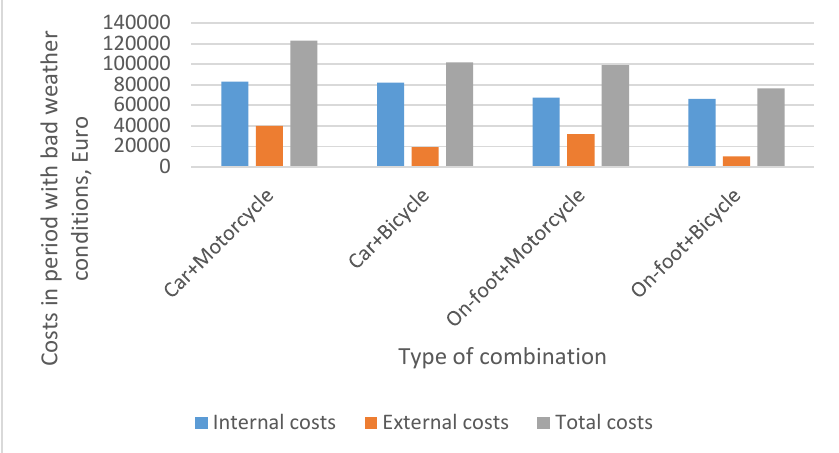
Figure 4: Internal, external and total costs of various combinations of urban delivery modes